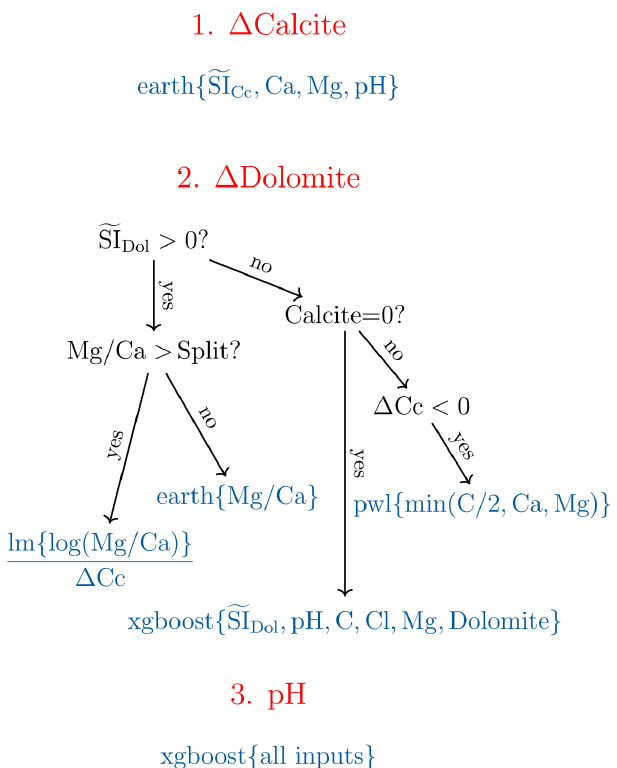
Figure 12. Comparison of variable profiles for coupled simulations using the decision tree approach versus the references at the end of the time steps used for training for grid 50 (41 coupled iterations). The axes are the same as in Fig. 2. (a) Decision tree trained on the data from reference grid 50 ( (cid:49)t = 1066s). (b) Surrogate sim- ulations using a decision tree trained on grid 500 ( (cid:49)t = 106 . 6s), repeated 10 times for each coupling time